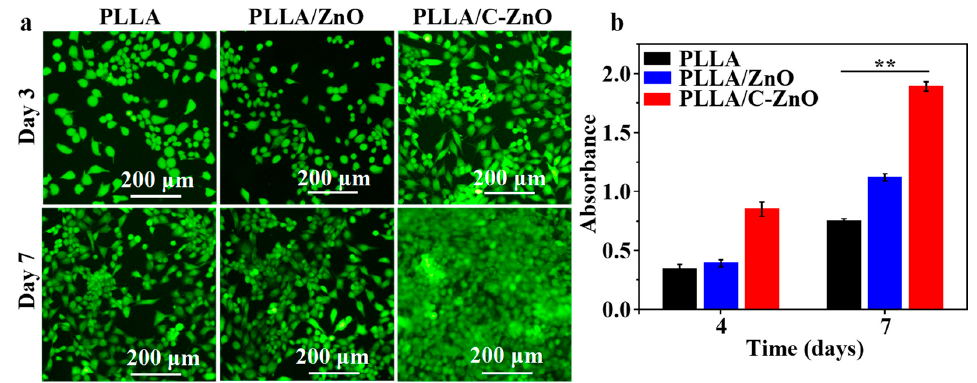
Figure 5. The fluorescence assay results: ( a ) fluorescence images and ( b ) the results of the CCK-8 assay ( n = 2, ** p < 0.01).